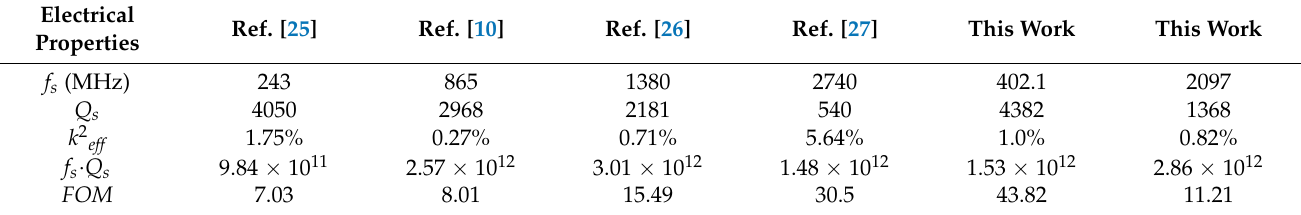
Table 4. The key performance parameters of the fabricated LWRs, compared to a variety of reported LWRs. Electrical